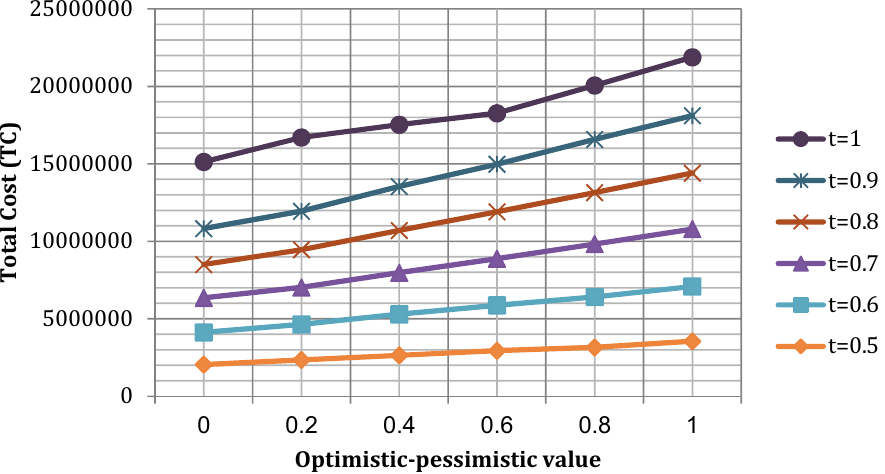
Fig. 1. Total costs based on the different optimistic-pessimistic values and confidence levels for UAM corresponding equivalent single objective ILP